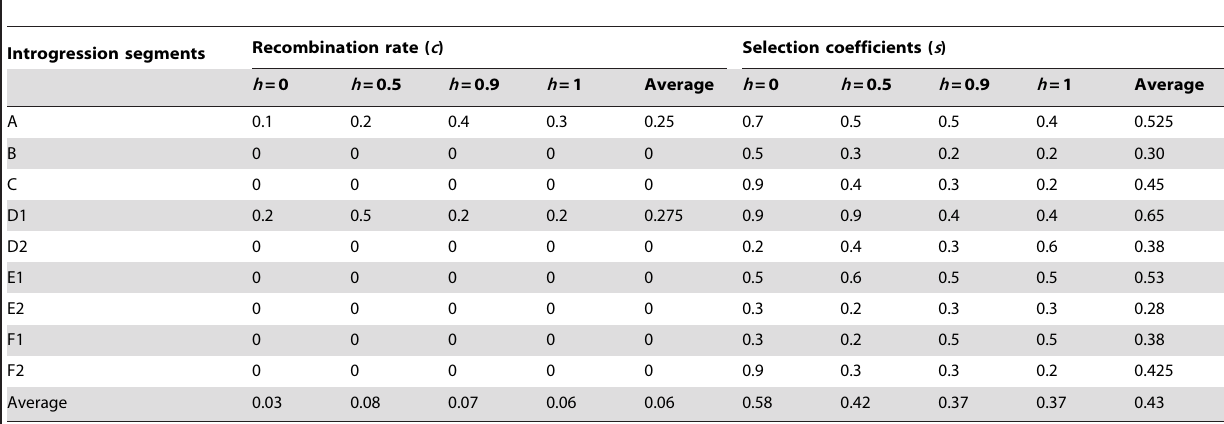
Table 2. Summary of maximum likelihood estimates of recombination rate ( c ) and selection coefficient ( s ) parameters with different dominance ( h ).